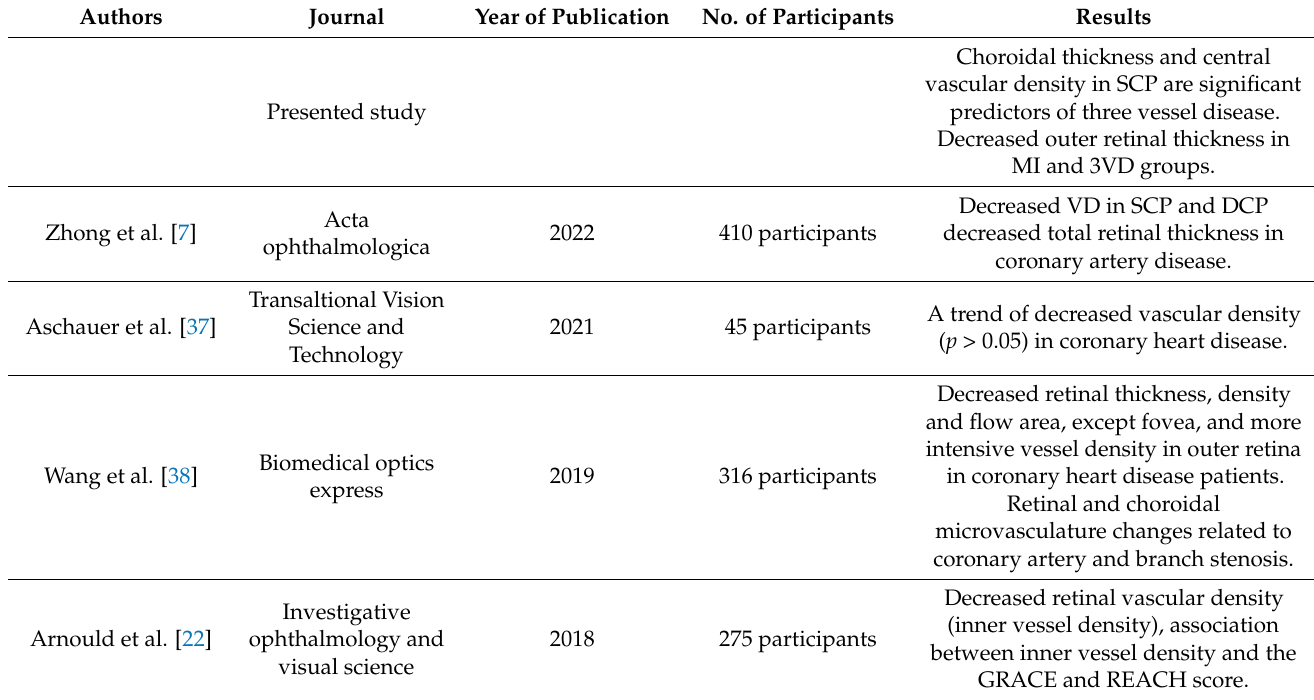
Table 4. OCT and OCTA results of the studies investigating coronary heart